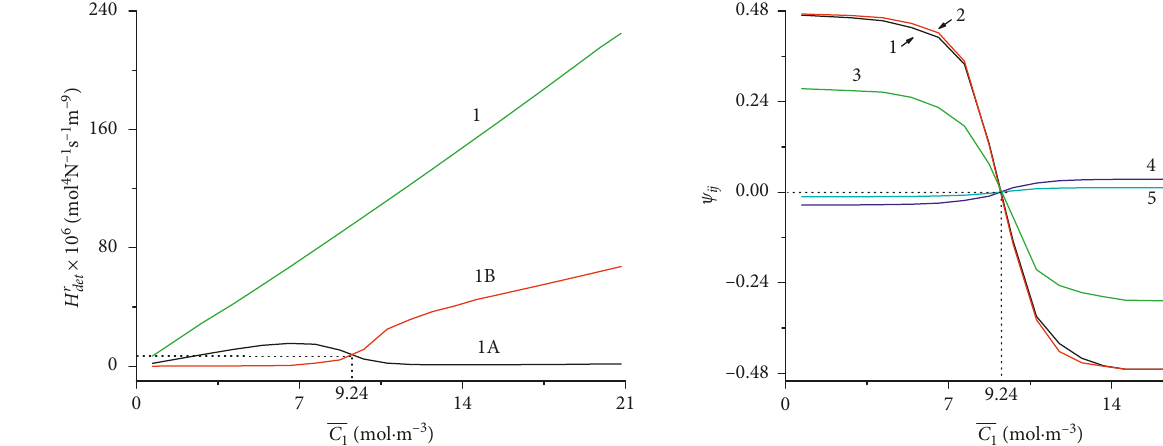
f ( C 1 , det (cid:31) Figure 10: The graphic illustration of the dependence aqueous ethanol solution in conditions of concentration polari-